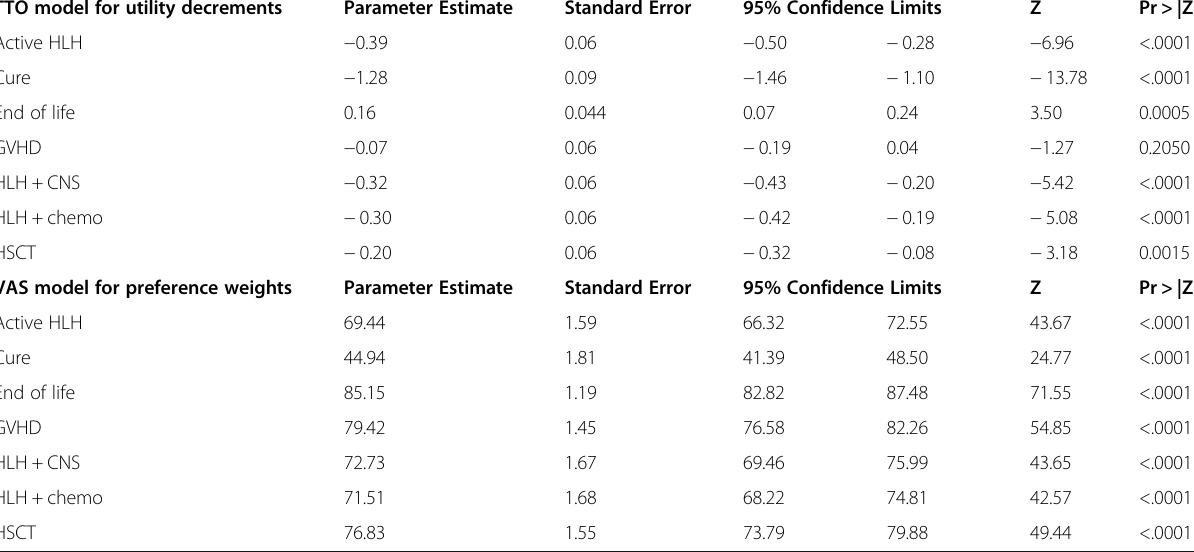
Table 2 Parameters of the regression for the TTO utility weights and for the VAS preference weights for the HLH states TTO model for utility